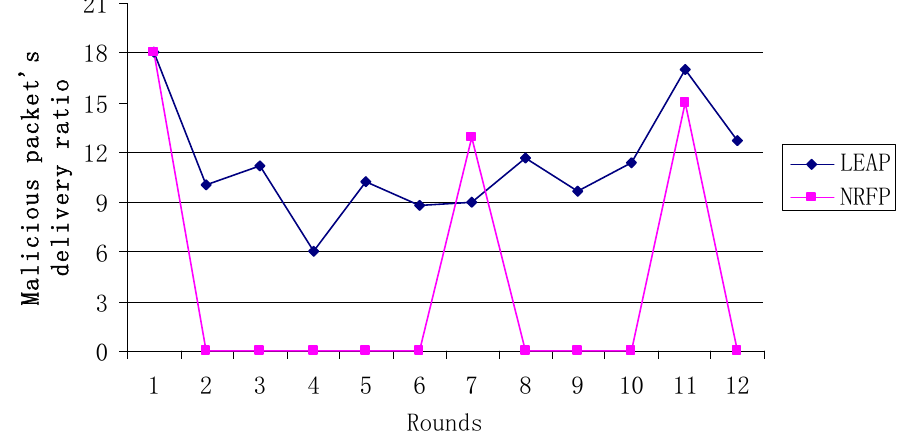
Figure 10. Average of malicious data rate are